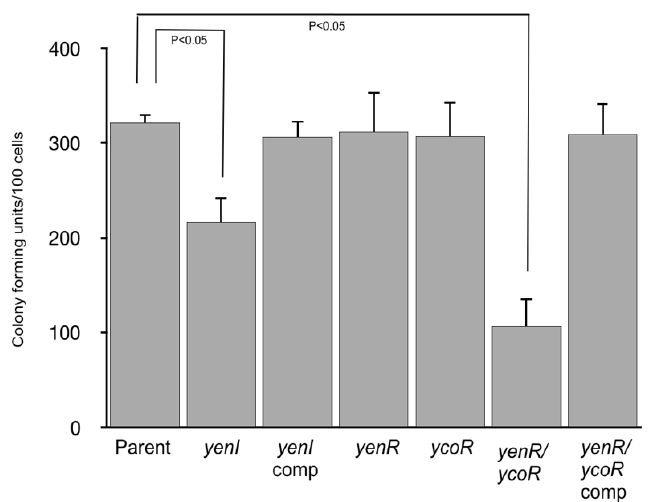
Figure 4. Attachment to human colorectal adenocarcinoma Caco-2 cells. The yenI and yenR / ycoR mutants showed a reduced ability to attach to Caco-2 cells. This phenotype was restored when functional copies of either yenI or yenR and ycoR , respectively, were supplied in trans ( yenI comp and yenR/ycoR comp).